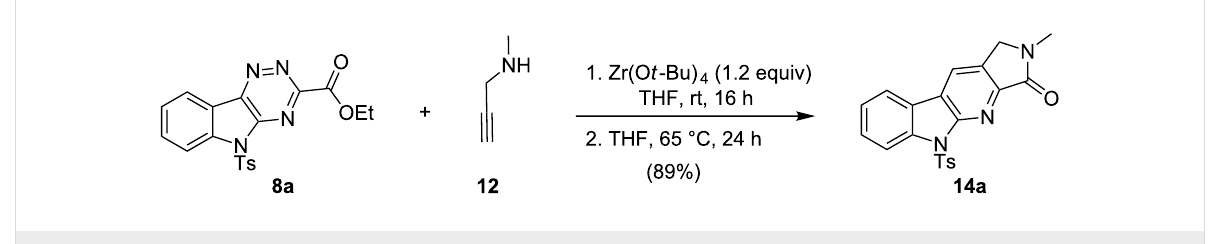
Scheme 5: One-pot amidation/cycloaddition of triazine ester 8a .